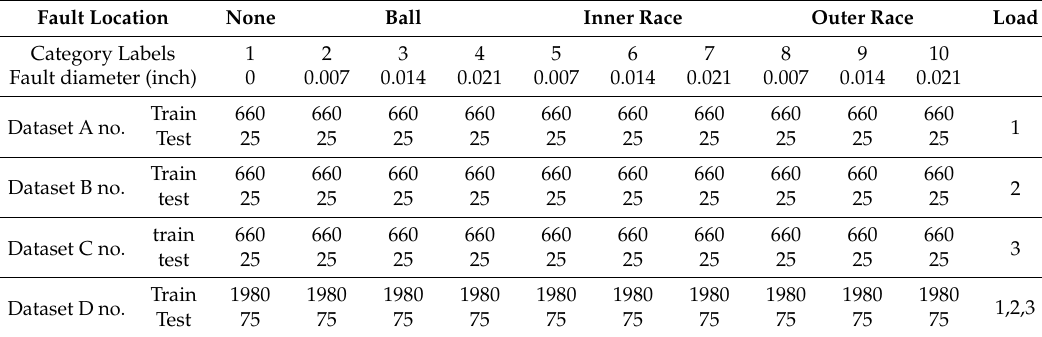
Table 1. Description of rolling element bearing